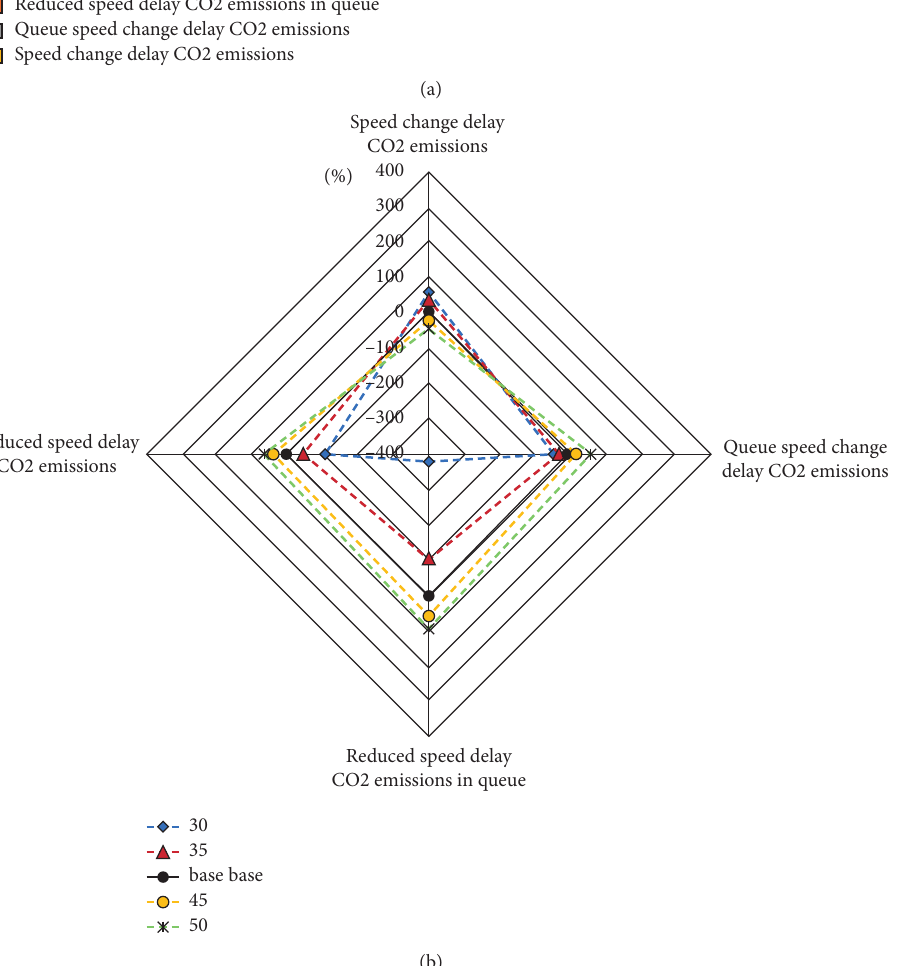
Figure 9: (a) Total work zone user CO 2 emissions; (b) potential reduction regarding different work zone user CO 2 emissions component under work zone limited